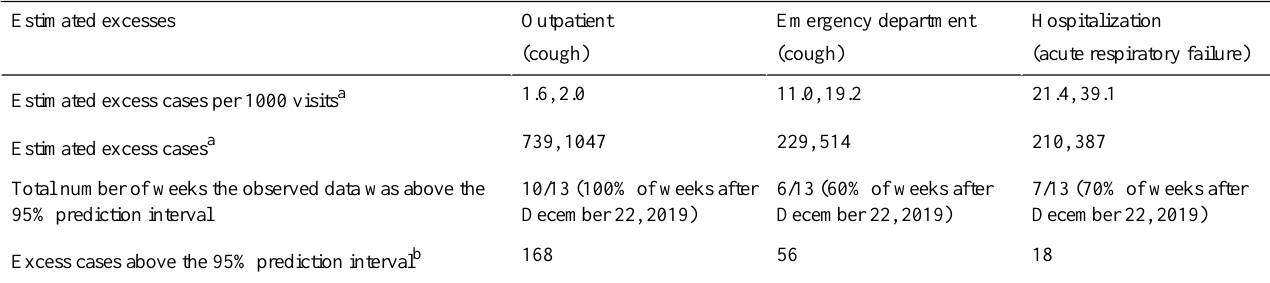
Table 2. Estimated excess cases during the 2019/2020 winter season via different